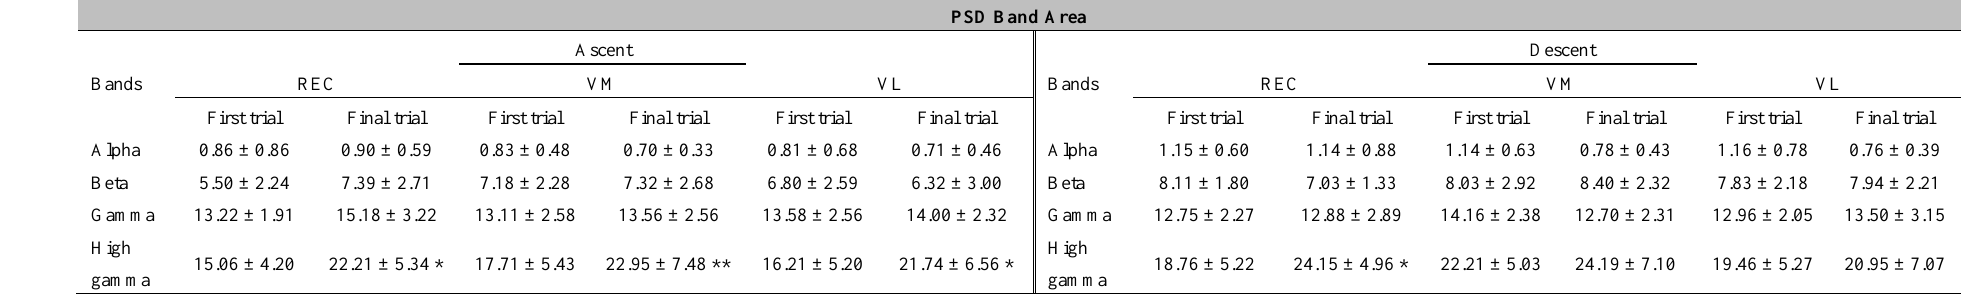
Table 3. Comparison of the changes in the area under the power spectrum curve different frequency bands (alpha band: 8–12 Hz; beta band: 15–30 Hz; gamma band: 30–60 Hz; high-gamma band: 60–120 Hz) in three muscles RF, VM, and VL between the initial and final trial of